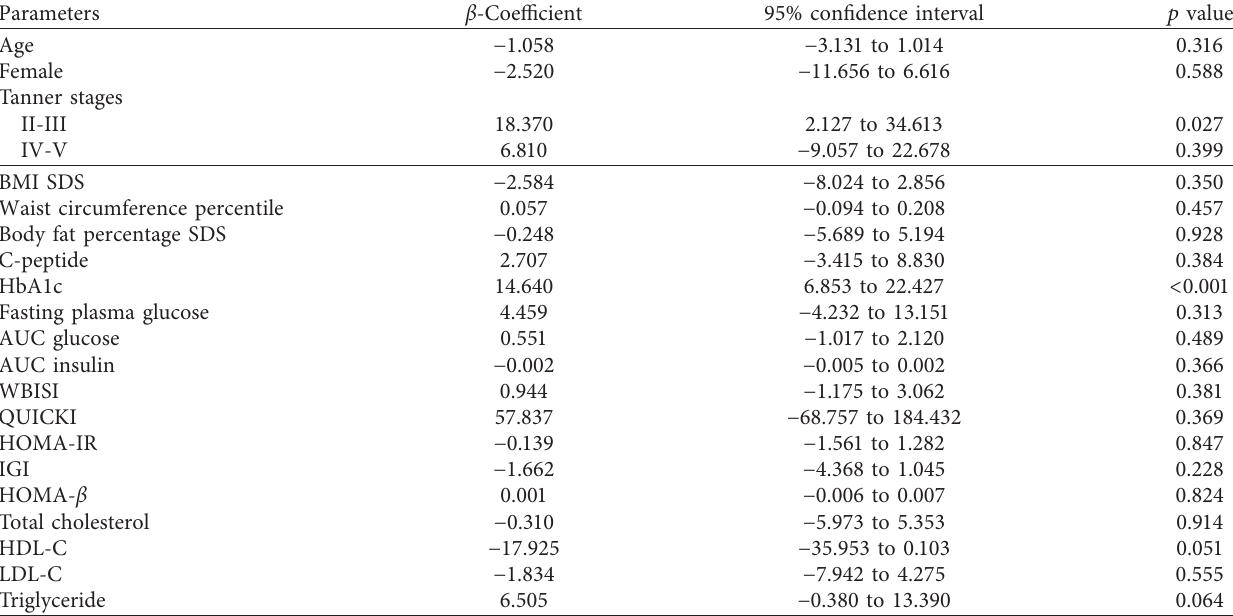
Table 2: Correlations between serum kisspeptin and other